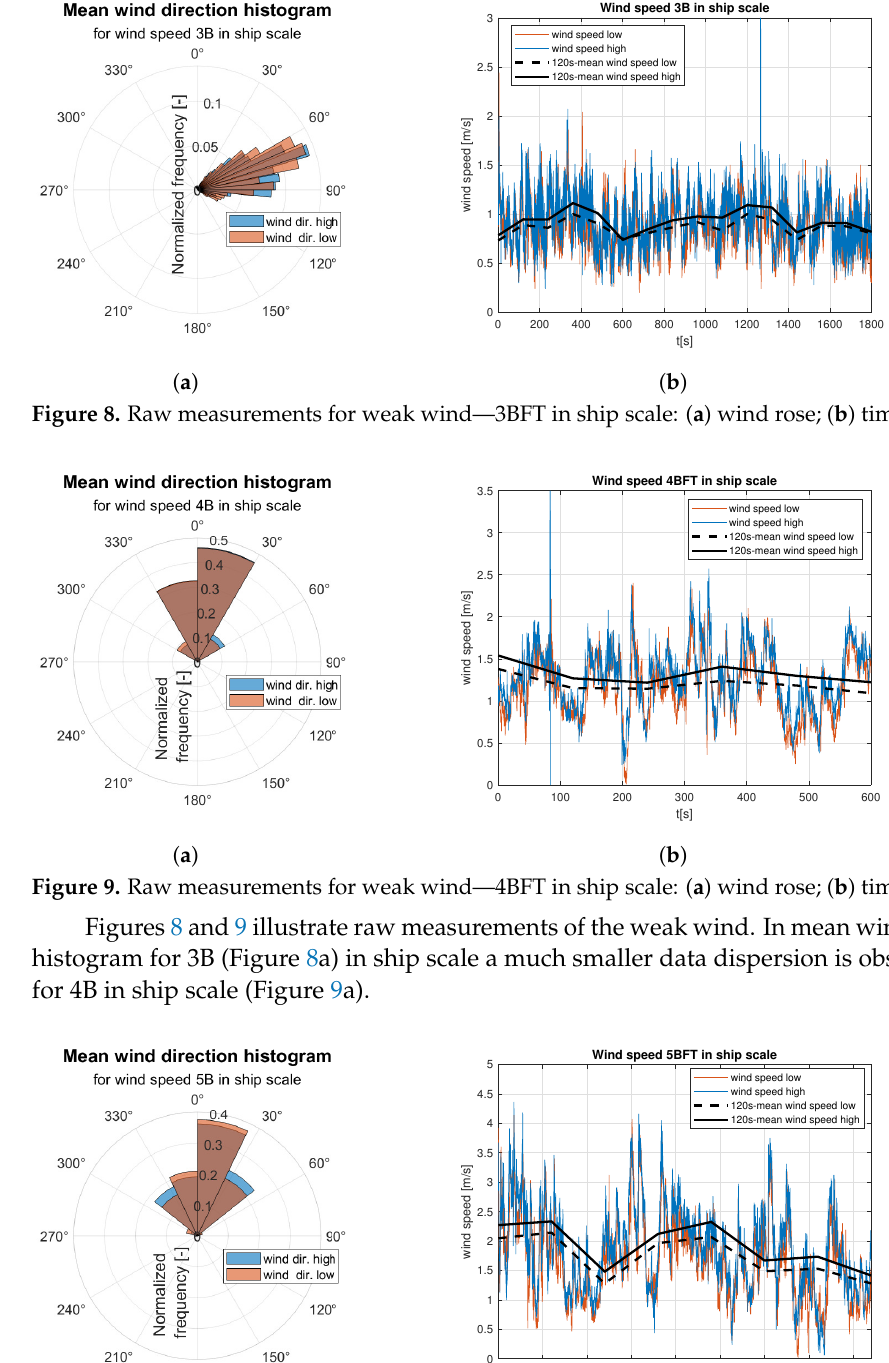
wind rose and wind speed time domain graph. Raw data are indicated by the red and blue lines according to the colors marked the “hull layer” (HL) and “superstructure layer” (SL) in Figure 1, respectively. It corresponds with “wind low” and “wind high” labels in Figures 8–14. Mean values of 120-s time spans are indicated by black solid and dashed lines for upper and lower anemometer measurements, respectively.